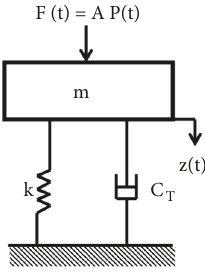
Figure 4: Lumped parameter model of the EMEH.